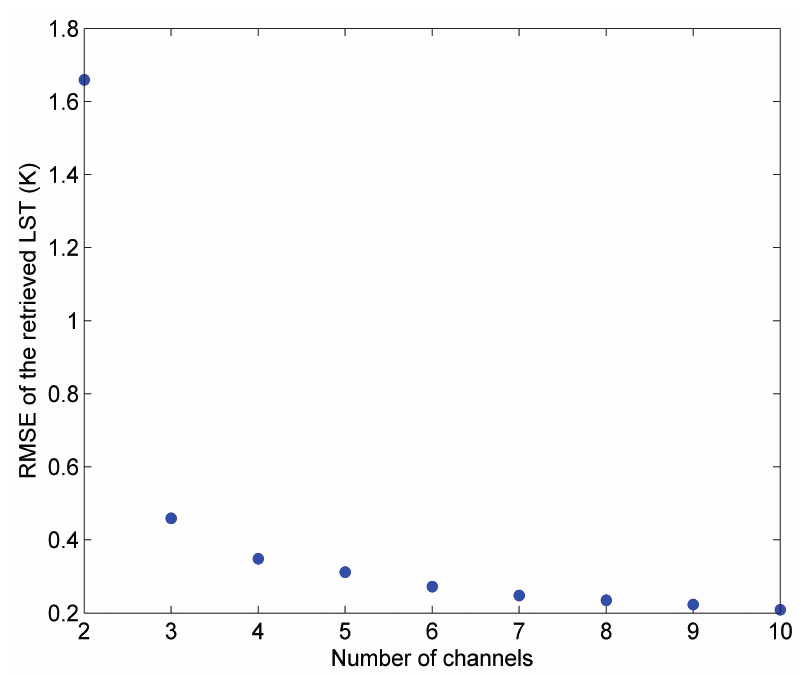
Figure 3. The variation of RMSE of the retrieved ST with the number of channels in the process for determination of centre wavenumbers and